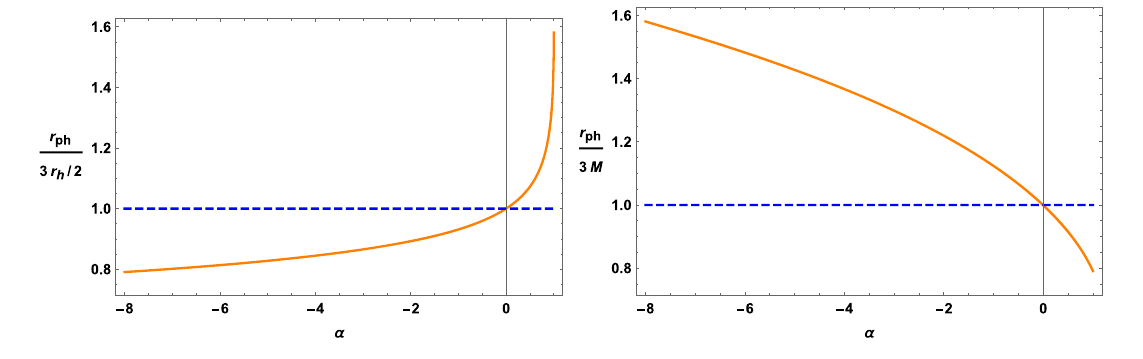
Fig. 3 the dependence of r ph